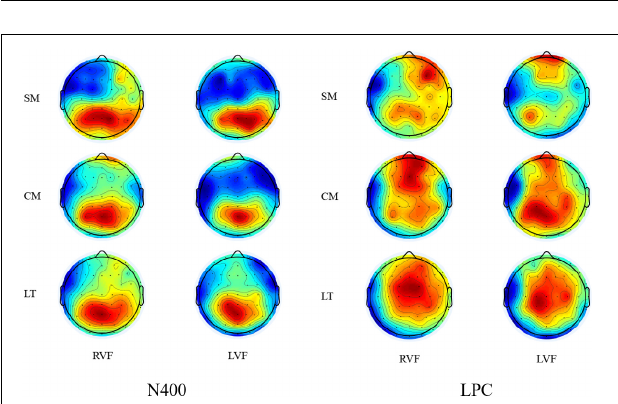
condition [ F (1,19) = 5.945, p = 0.025, η p 2 = 0.238].